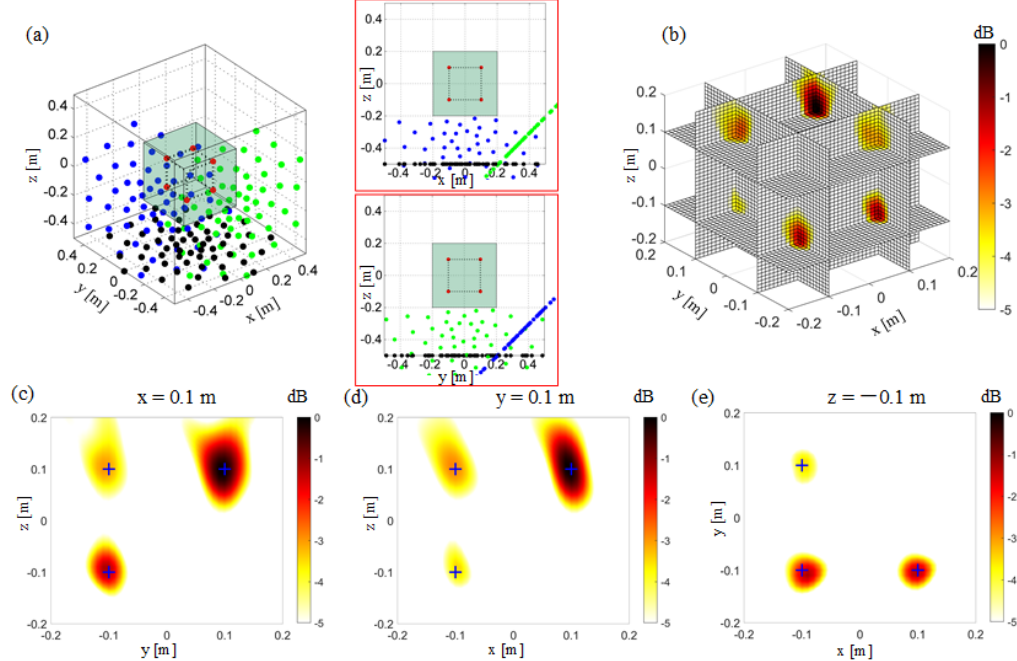
Figure 10. 3D Beamforming results from the non-synchronous measurements, non-orthogonally moving the array twice. ( a ) The simulation setup. The red points “ · ” represent the sound sources. The other same color represents the microphones in the same test. The black points “ · ” represent the microphones in a single planar array test. The blue points “ · ” represent the microphone in the test with the non-orthogonal moving array, moved here for the first time. The green points “ · ” represent the microphone in the test with the non-orthogonal moving array, moved for the second time. The first subfigure represents the view in the x–z plane, and the second subfigure represents the view in the y–z plane. ( b ) 3D beamforming map. ( c ) The beamforming map at the x = 0.1 m slice. ( d ) The beamforming map at the y = 0.1 m slice. ( e ) The beamforming map at the z = − 0.1 m slice.